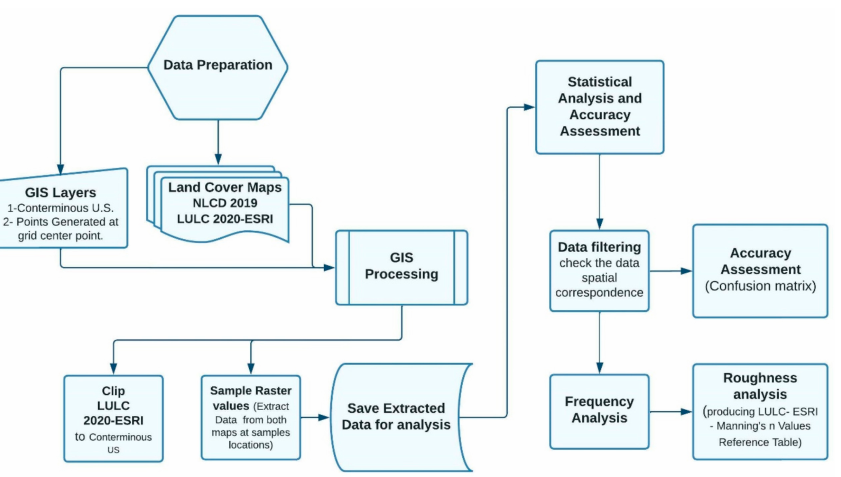
Figure 3. Research methodology for part 1: data preparation, accuracy assessment, and roughness analysis.